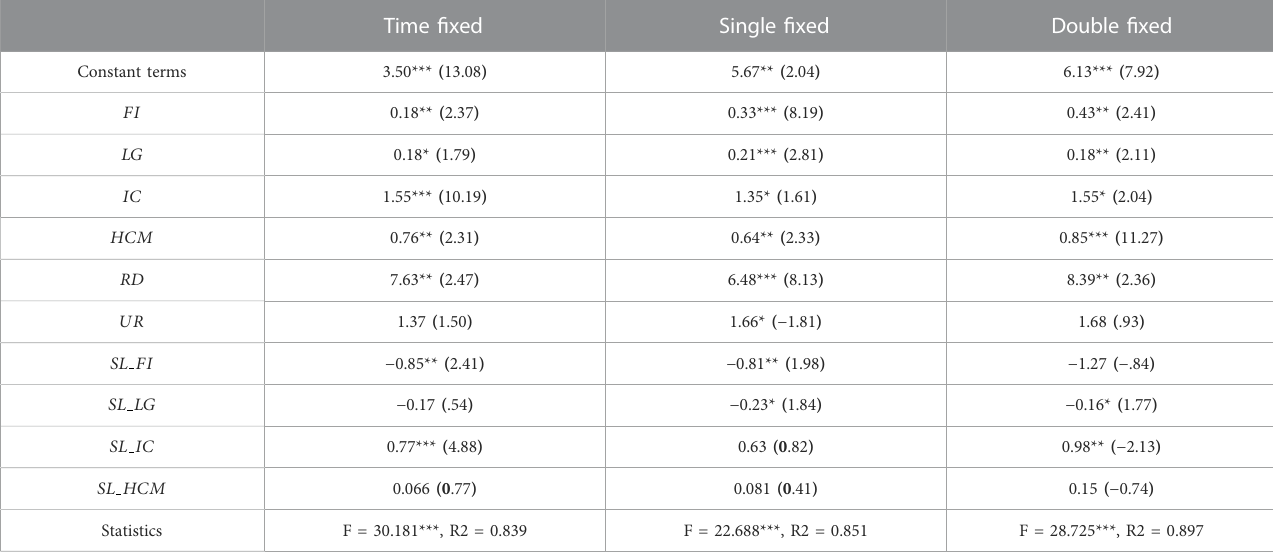
TABLE 4 Model calculation